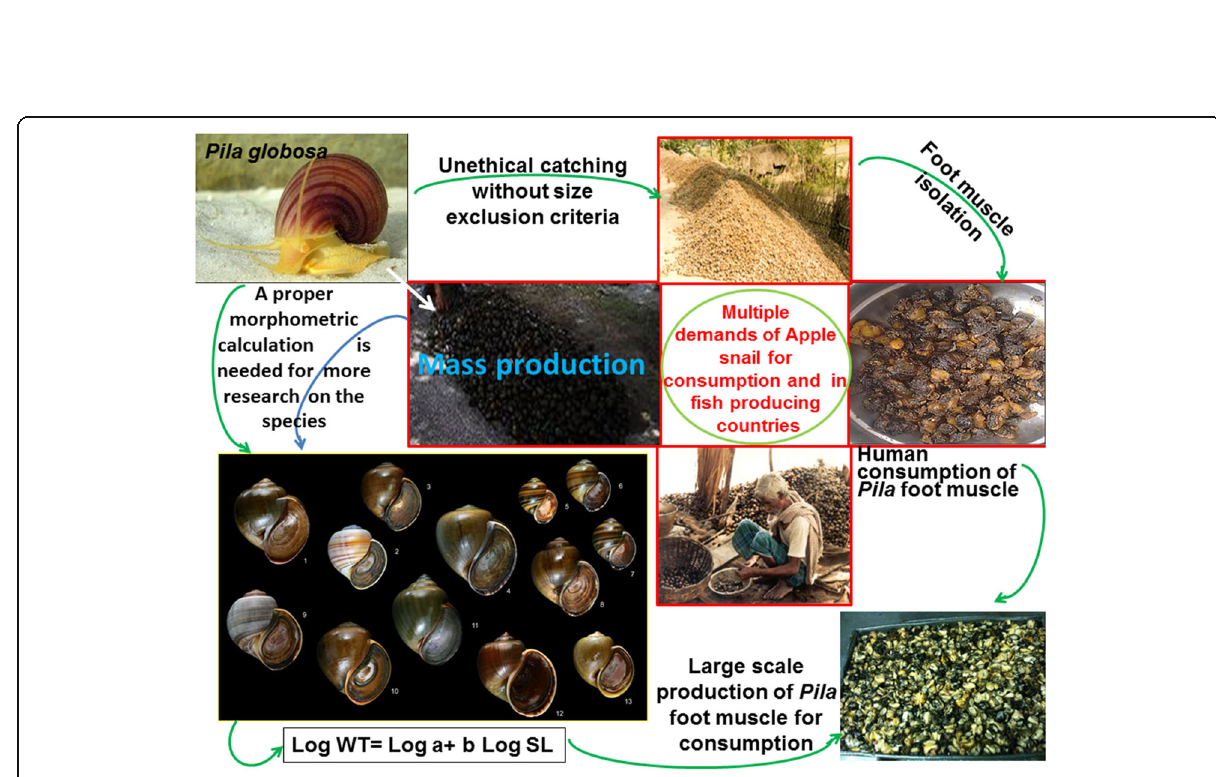
Fig. 7 Mass production of Pila globosa for its current and future use. Figure indicates that the apple snail P. globosa has a tremendous current use. They are used as fish bait and fish feed in many conventional aquaculture subsystems. For mass production and morphological segregation, a county-wise morphometric study is there for suggested. Pila is directly used for human consumption in many parts across the world. At least 13 varieties of the species are identified and consumed both by human and in aquaculture